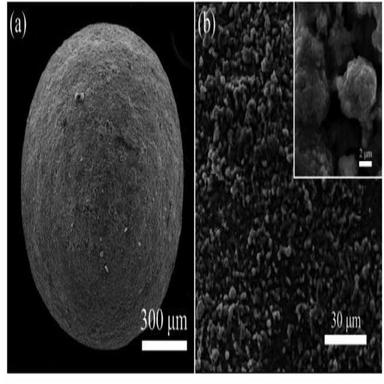
SEM surface morphology of the pebbles sintered at 1123 K in air.